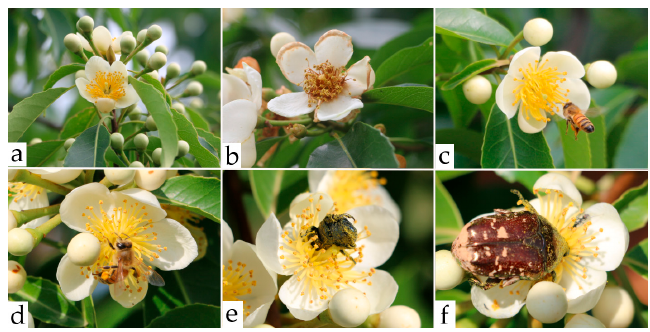
Figure 1. The flowers and pollinators of Schima superba Garden. et Champ.